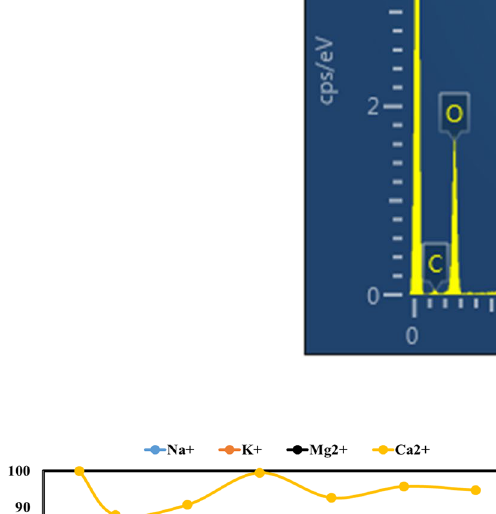
Fig. 10 Elemental composition of the activated clay (after the activation)